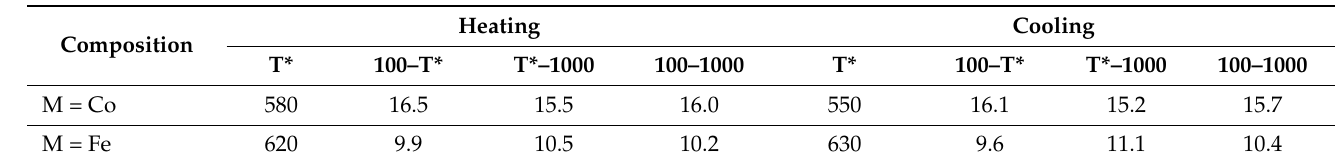
Table 1. Low-temperature, high-temperature, and average TEC values of PrNi 0.4 M 0.6 O 3– δ determined within various temperature ranges and regimes.